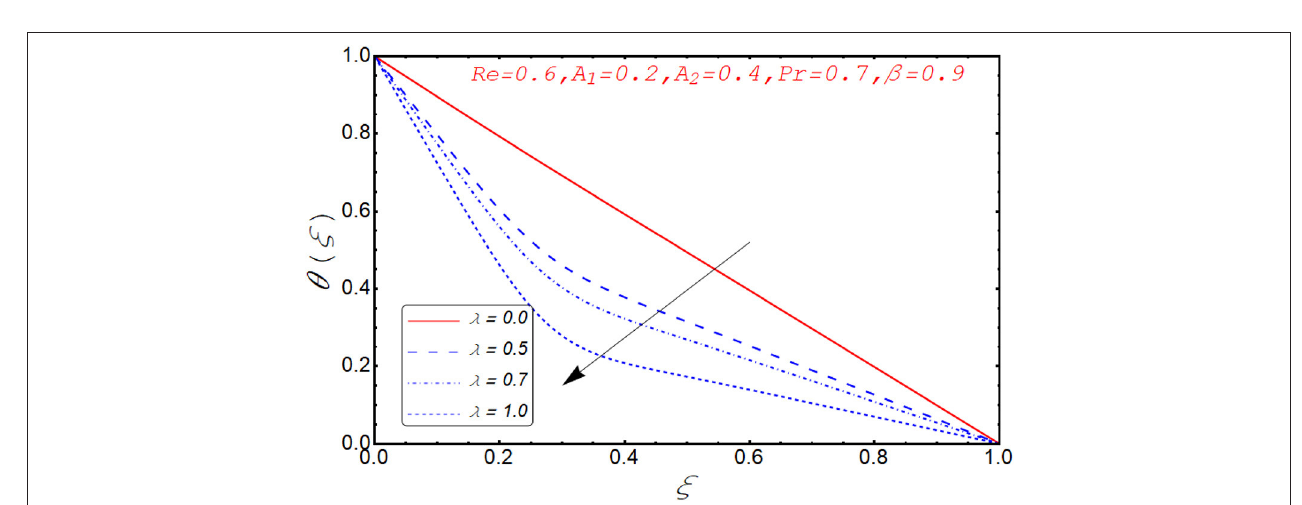
FIGURE 16 | Behavior of θ ( ξ ) for different Pr.